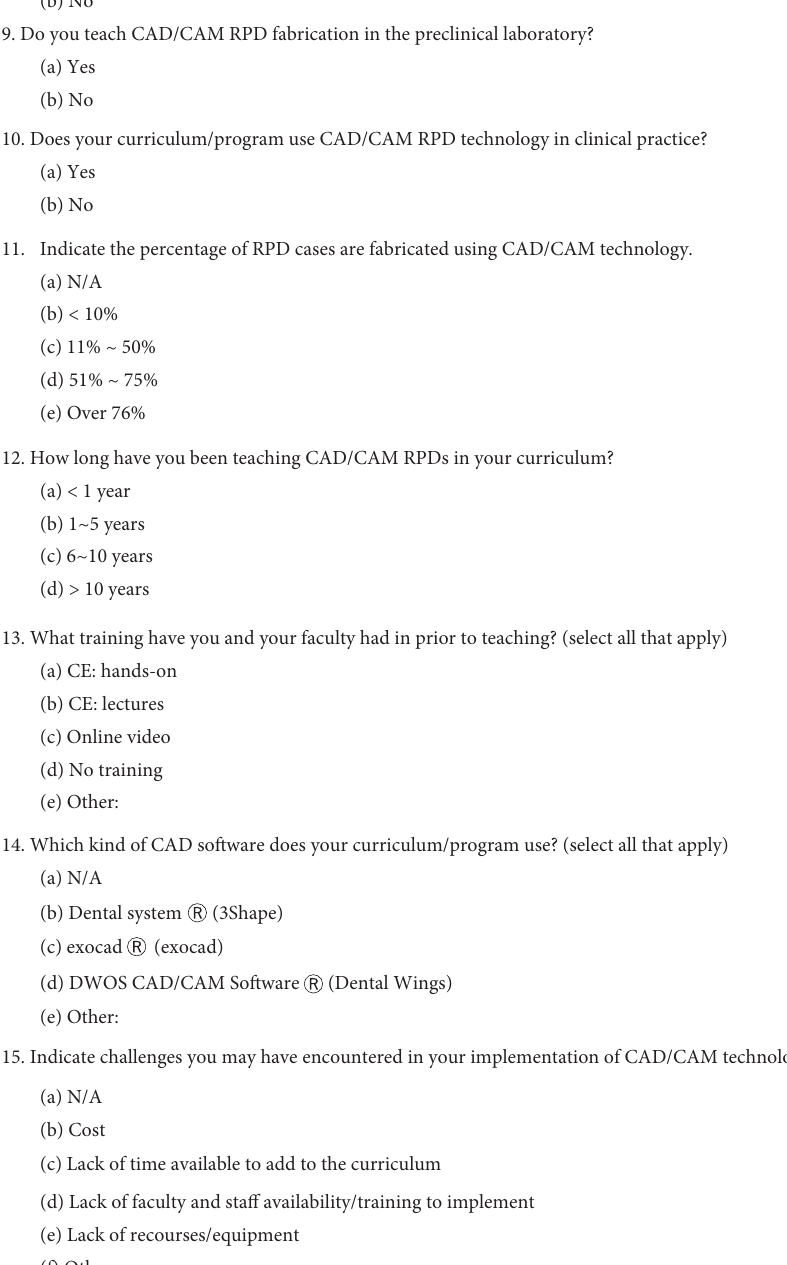
Figure 1: Questionnaire distributed to the directors of predoctoral prosthodontics of schools and advanced graduate prosthodontics programs of schools listed in the 2018–19 American Dental Education Association